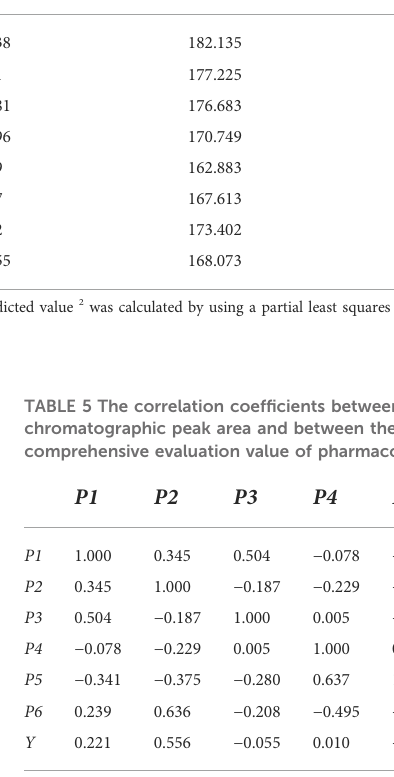
TABLE 4 The predicted value, actual value, and D-value of pharmacodynamic comprehensive evaluation value (Y). Y (actual value)